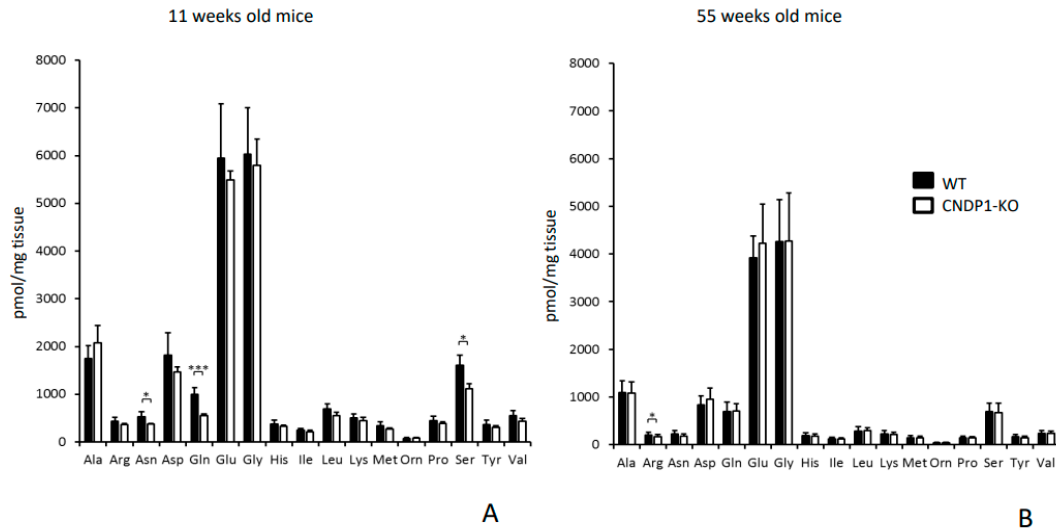
Figure 3. Amino acid profiles of kidneys measured by UPLC of 11- ( A ) and 55- ( B ) week-old Cndp1 -KO ( n = 4 and n = 14) and WT mice ( n = 4 and n = 14). In 11-week-old mice, asparagine, glutamine and serine were decreased in Cndp1 -KO mice compared to WT mice. In 55-week-old mice, arginine was decreased in Cndp1-KO compared to WT mice *: p < 0.05; ***: p < 0.001.